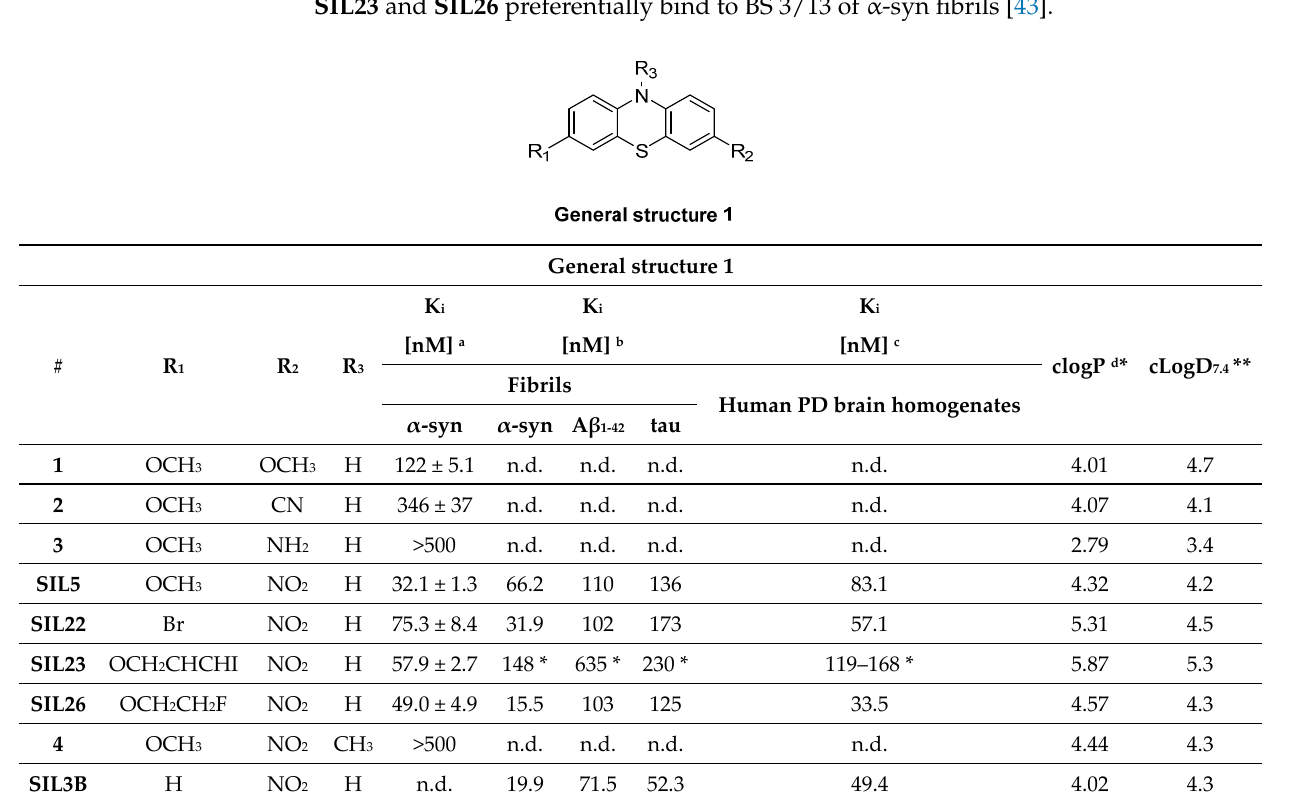
Figure 6. Phenothiazine analogues with binding properties determined from two different assays. a Affinity toward α -syn fibrils determined by ThT fluorescence assay. [92] b Affinity toward recombinant α -syn and tau and synthetic A β 1-42 fibrils determined by [ 125 I]SIL23 competition assay [55]. c Affinity toward human PD brain homogenate determined by [ 125 I]SIL23 competition assay [55]. * K d value determined with the radioligand [ 125 I]SIL23 on fibrils or human PD brain homogenate. * clogP computed from BioByte software. ** clogD 7.4 computed from ACD/Percepta. n.d.: not determined.